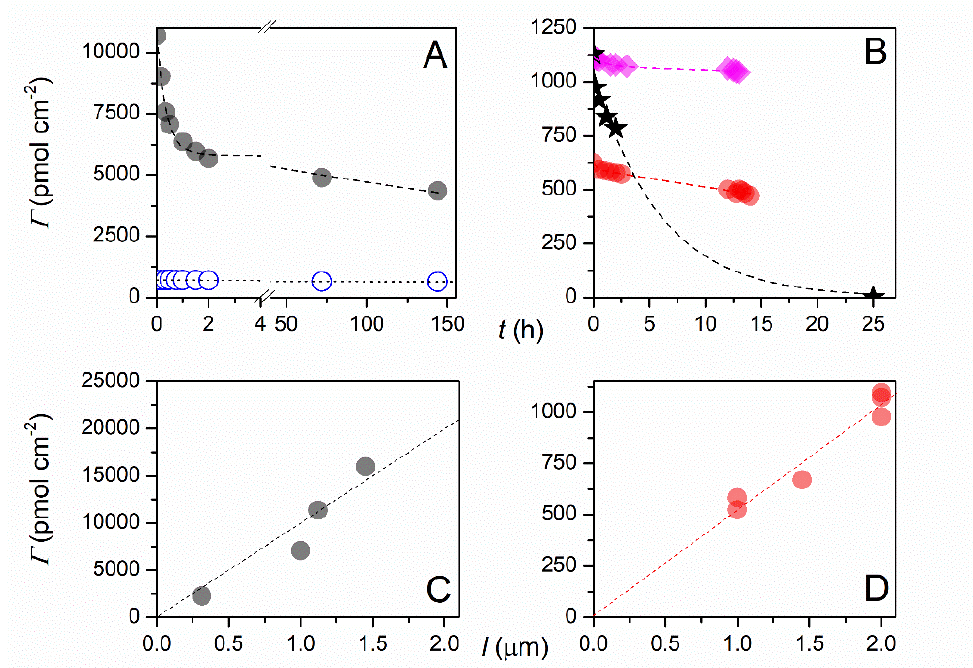
Figure 8. Surface coverage at 1 μ m thick ITO electrodes as a function of soaking time in the electrolyte (0.3 M KCl + 0.1M pH 7.5 HEPES buffer) for: ( A ) ( ● ) ferrocene and ( Ο ) TAPP, ( B ) ( ● ) rN6KHbI. In ( B ), the coverage data are compared to that obtained at a ( ♦ ) 2 μ m thick rN6KHbI-ITO electrode and a ( ★ ) 1.45 μ m thick ITO electrode. All experimental data are fitted to a bi-exponential decay function. ( C , D ) Surface coverage of ( ● ) ferrocene and ( ● ) rN6KHbI at ITO electrodes of varying film thicknesses l after 2–3 h soaking in the electrolyte [162].